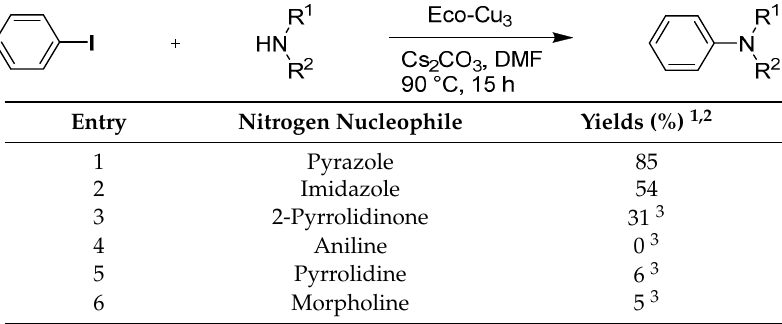
Table 7. The extension of the Ullmann reaction to other nitrogen nucleophiles.